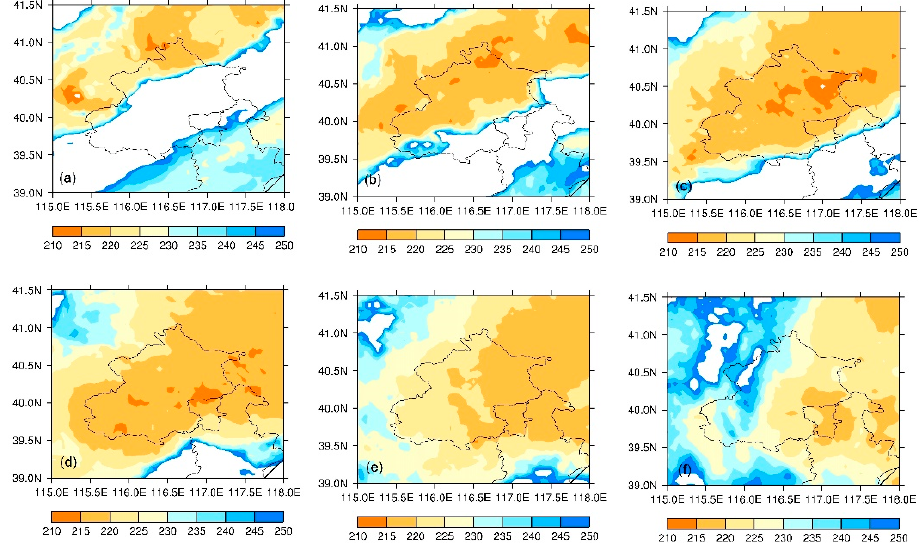
Figure 2. Spatial distribution of hourly satellite brightness temperatures (BTs, unit: K) from Himawari-8 in Beijing on 1 July 2021. ( a − f ) Infrared BTs (11.2 μ m) at 15:00 − 20:00 BJT.